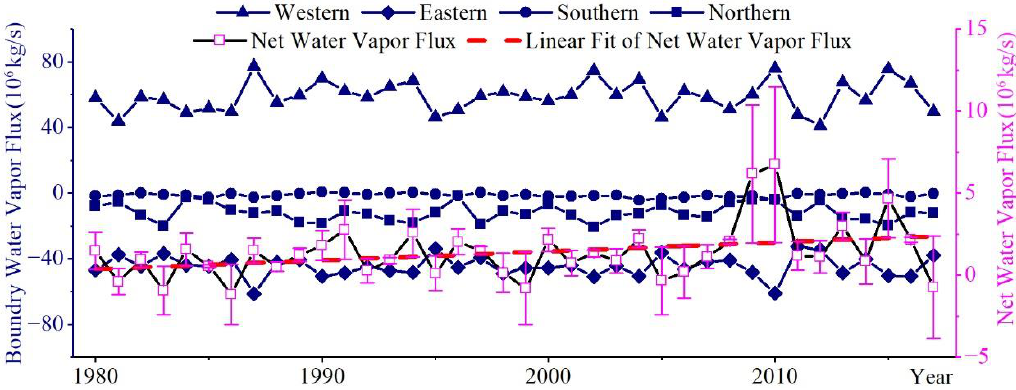
Figure 5. Changes in the water vapor budget at each border and the net budget of snow season over Northern Xinjiang from 1980 to 2017. The linear fit of the net water vapor flux passed the 95% confidence test. The boundary box can be seen in Figure 4 in black (79 – 92° E, 41 – 50° N).